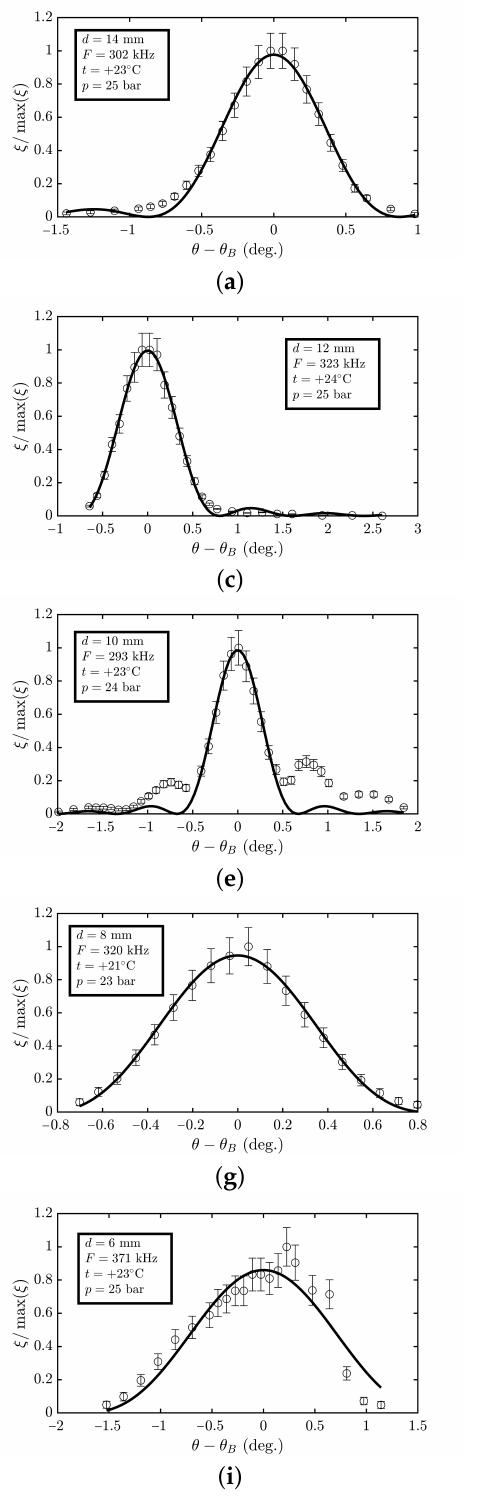
Figure 5. Experimental results: ( a , c , e , g , i ) AO diffraction efficiency ξ / max ( ξ ) vs. difference between angle θ of incidence of THz radiation on AO cell and Bragg angle θ B ; ( b , d , f , h , j ) frequency dependence of AO diffraction efficiency per 1 W of input electric